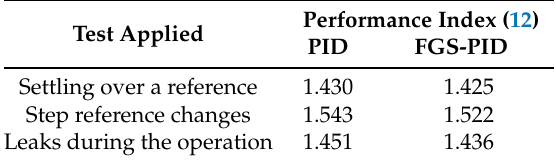
Table 6. Controller performance comparison during simulation.